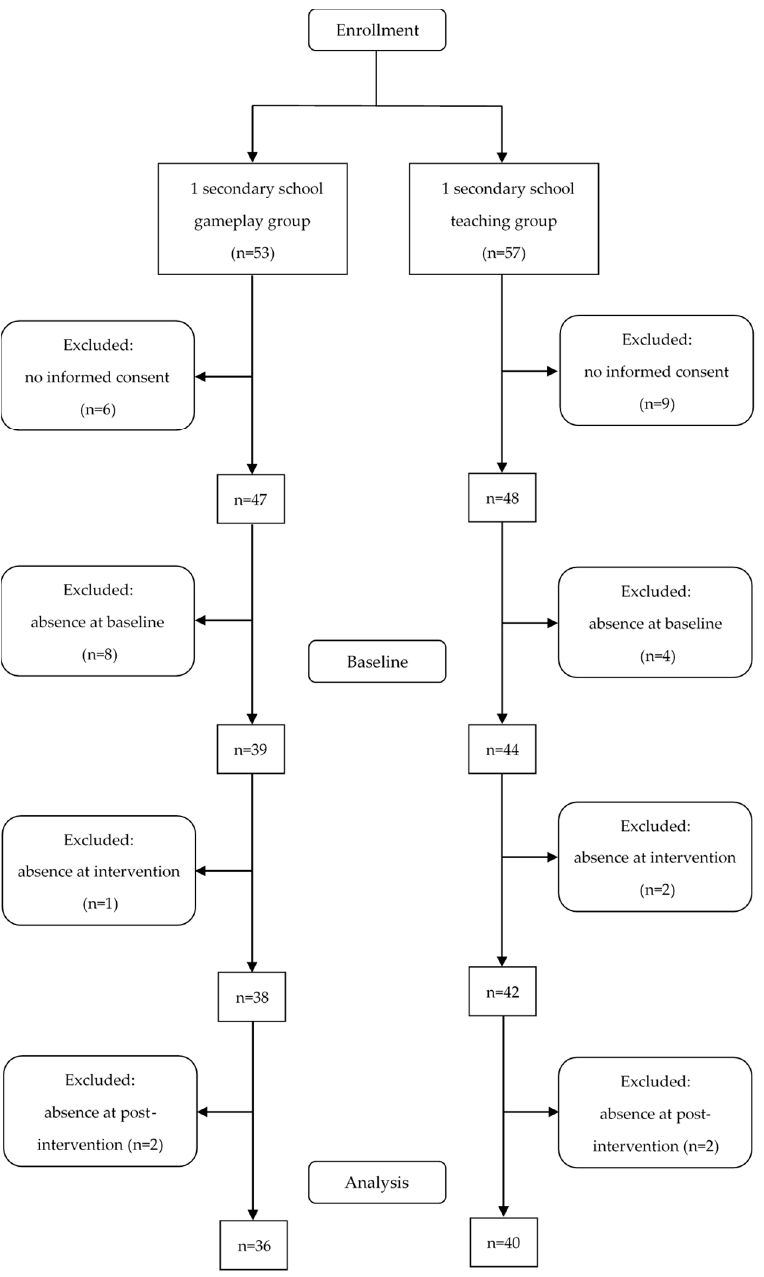
Figure 1. Flow diagram of study participants.